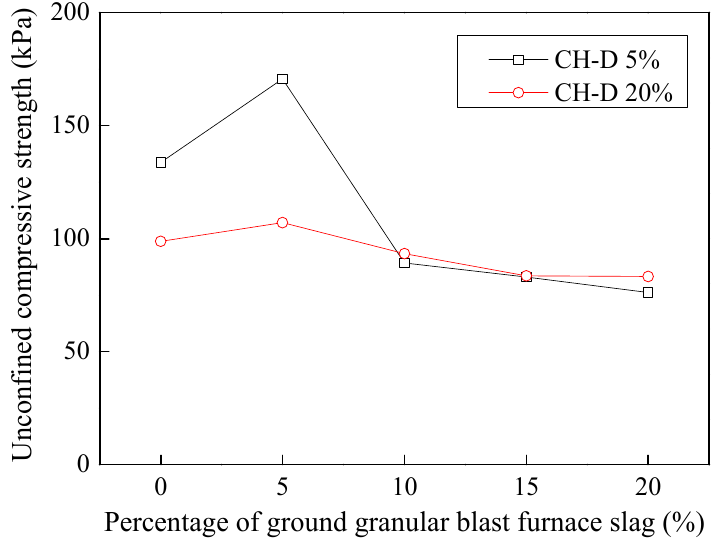
Figure 23. Improvement in dyeing effluent contaminated CH soil using GGBFS.